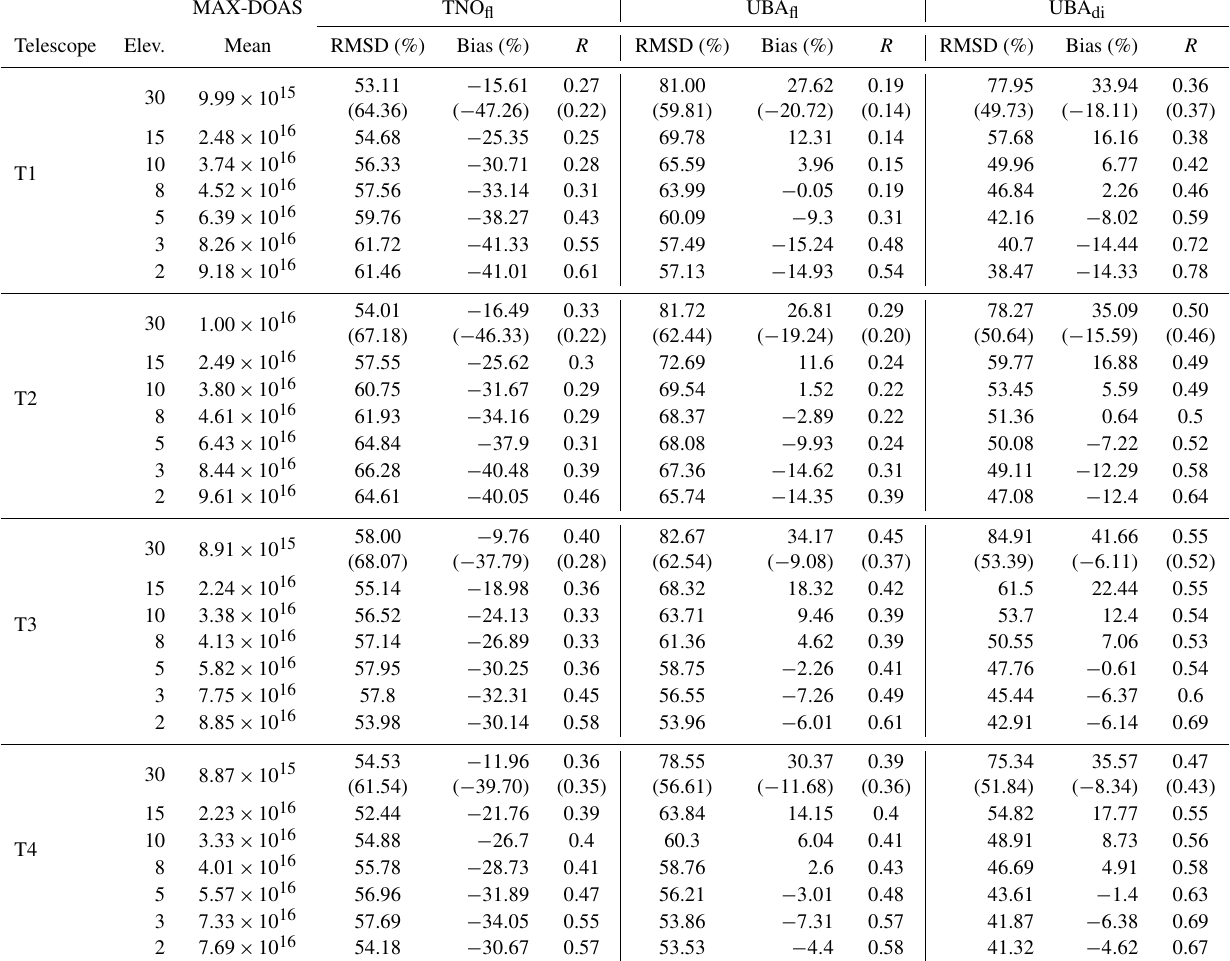
Table C3. Same as Table C2 but for cloud-free cases only.